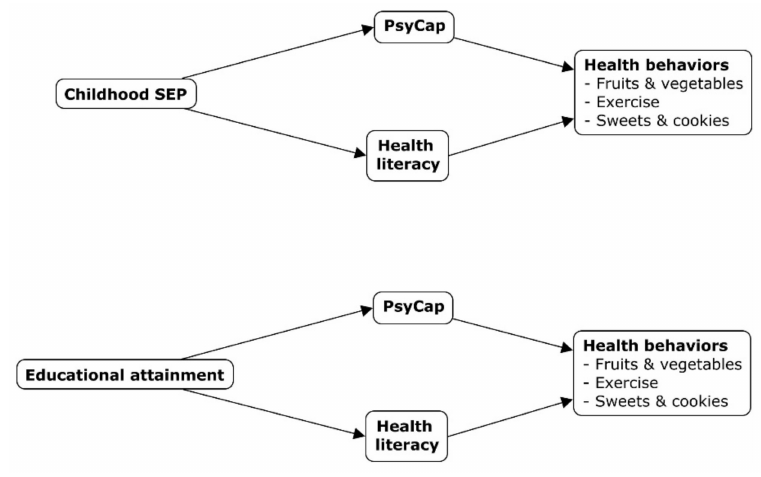
Figure 1. Schematic overview of conducted mediation analyses. Table 2. Summary of mediation analyses; using childhood SEP and adult education as independent variables and PsyCap and health literacy as (parallel) mediator